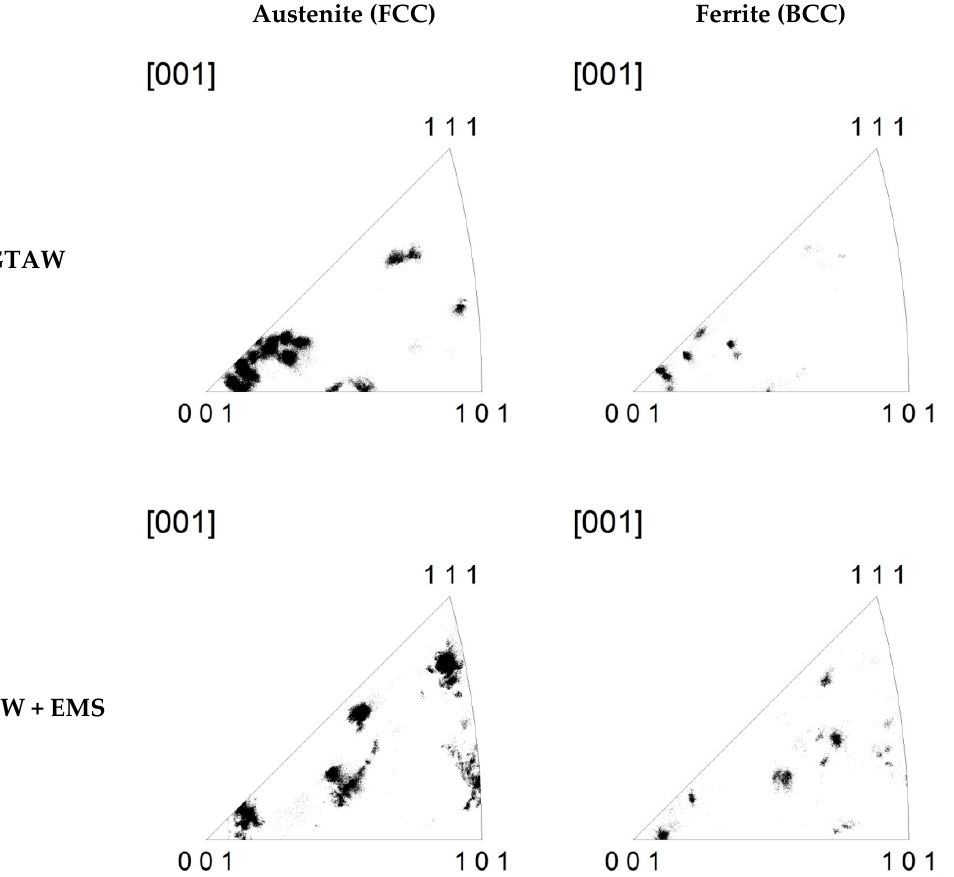
Figure 7. The inverse pole figures of austenitic and ferritic grains in the bead-on-plate (BOP) welds.